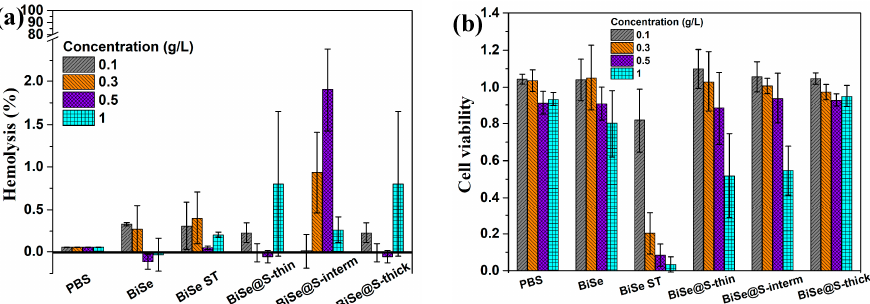
Figure 5. Influence of silica coated Bi 2 Se 3 nanoparticles compared to their pristine and ethylene glycol coated counterparts on red blood cells toxicity ( a ) and HeLa cell viability ( b ). Cells were exposed to different concentrations of nanoparticles and compared with the control (PBS medium). Negative control for hemotoxicity was 0%, and control for HeLa cell viability was 1.